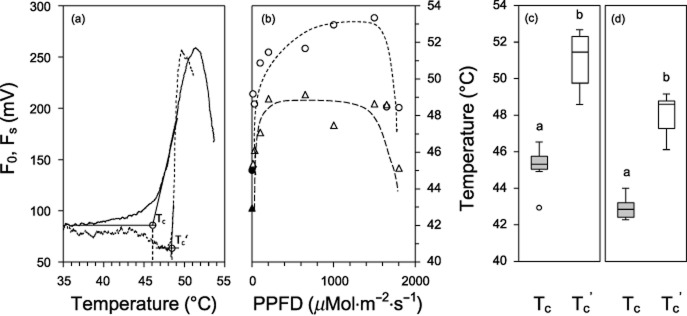
Critical high temperature threshold of PSII. (a) Typical T-F0 plot (temperature-basic fluorescence) for determination of Tc determined during controlled heating in darkness (solid line) compared with steady-state fluorescence (dotted line) recorded during controlled heating in the light (1600 μmol photons·m−2 s−1). At critical temperatures (Tc in darkness, Tc′ in the light), the chlorophyll fluorescence signal shows a distinct increase. (b) Tc and Tc′ determined on leaves of Senecio incanus (circles) and Ranunculus glacialis (triangles) as a function of irradiation intensity. Tc is lowest (solid symbols, n = 5). Tc′ (open symbols) increases with irradiation intensities, initially steeply in both species, then plateaus and after reaching approximately 1800 μmol photons·m−2 s−1 drops again. Boxplots of Tc (grey boxes) and Tc′ (white boxes; PPFD from 30 to 1650 μmol photons·m−2 s−1) in leaves of (c) S. incanus and (d) Ra. glacialis. Significant differences between mean values based on the Student's t-test (P < 0.01) are indicated by different letters.